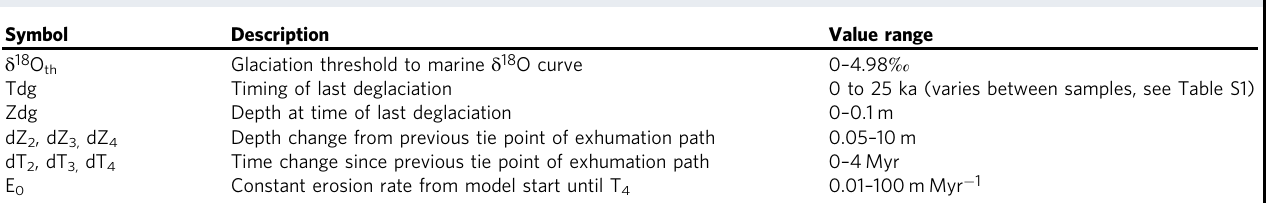
COMMUNICATIONS EARTH & ENVIRONMENT| (2023) 4:9